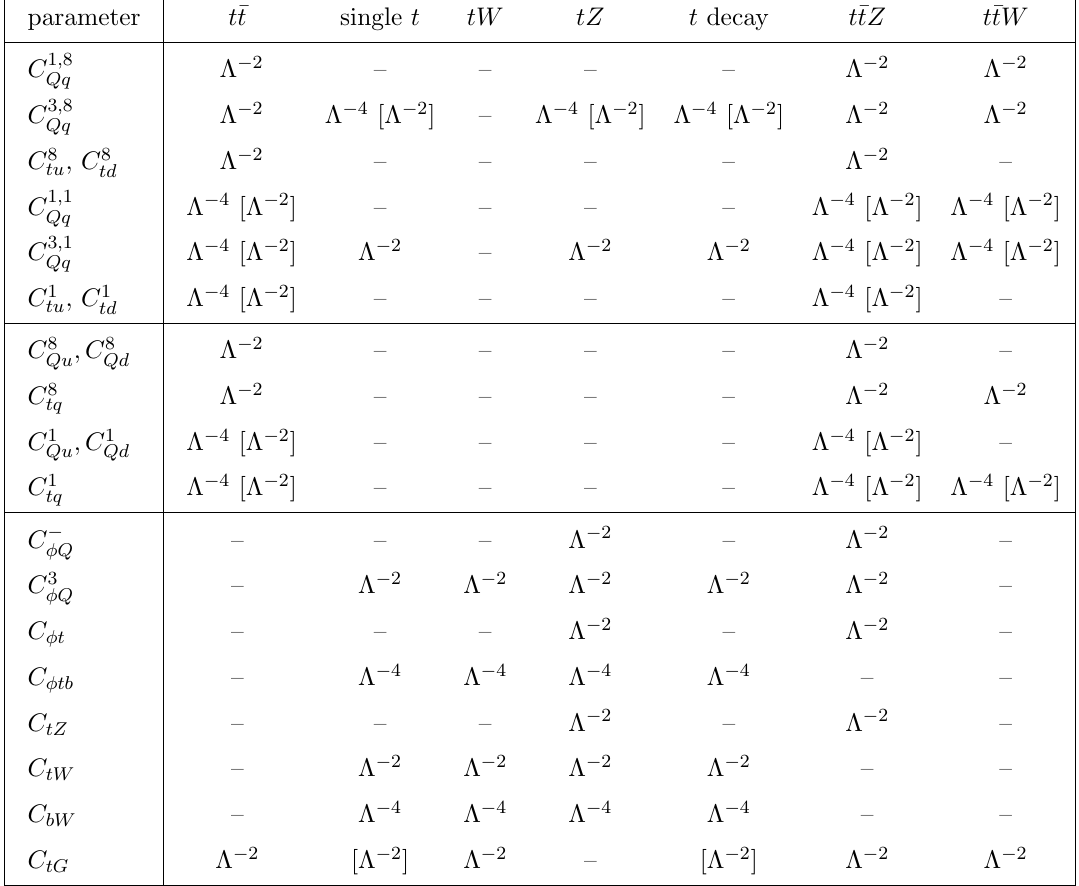
Table 1 . Wilson coe(cid:14)cients in our analysis and their contributions to top-quark observables via SM-interference ((cid:3) (cid:0) 2 ) and via dimension-6 squared terms only ((cid:3) (cid:0) 4 ). A square bracket indicates that the Wilson coe(cid:14)cient contributes via SM-interference at NLO QCD. All quark masses except m t are assumed to be zero. ‘Single t ’ stands for s - and t -channel electroweak top